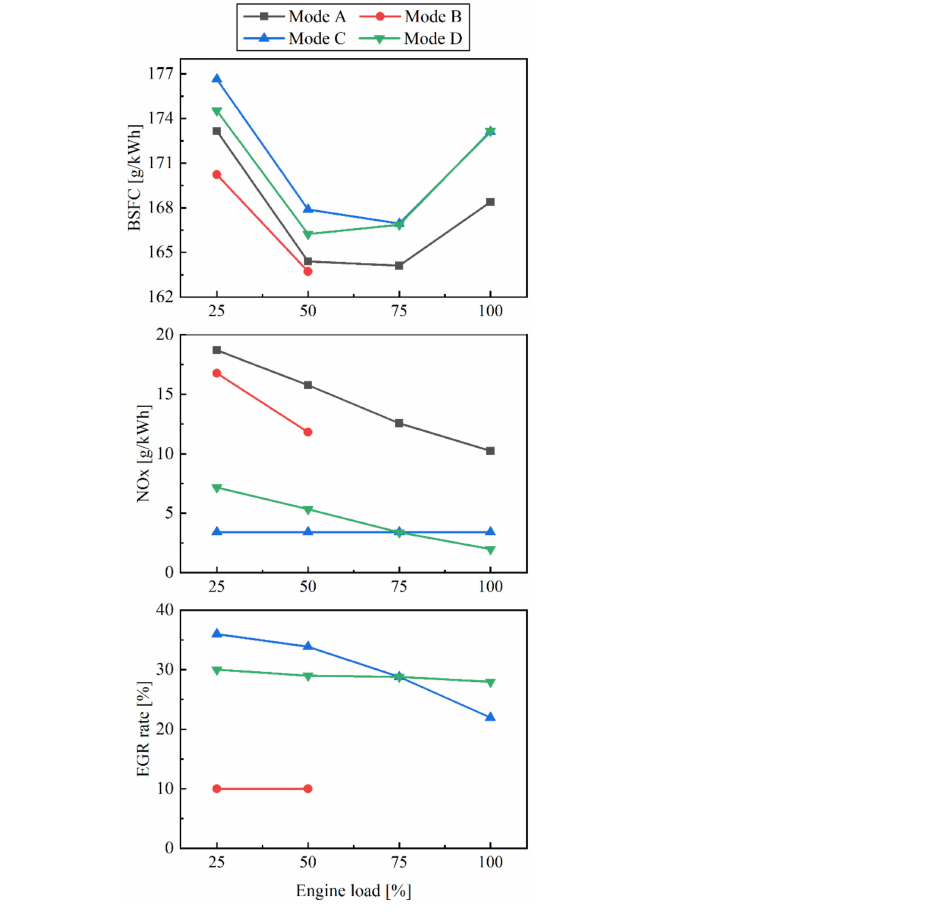
Figure 12. Predicted BSFC, NOx emissions, and required EGR rate for the four studied engine operating modes.